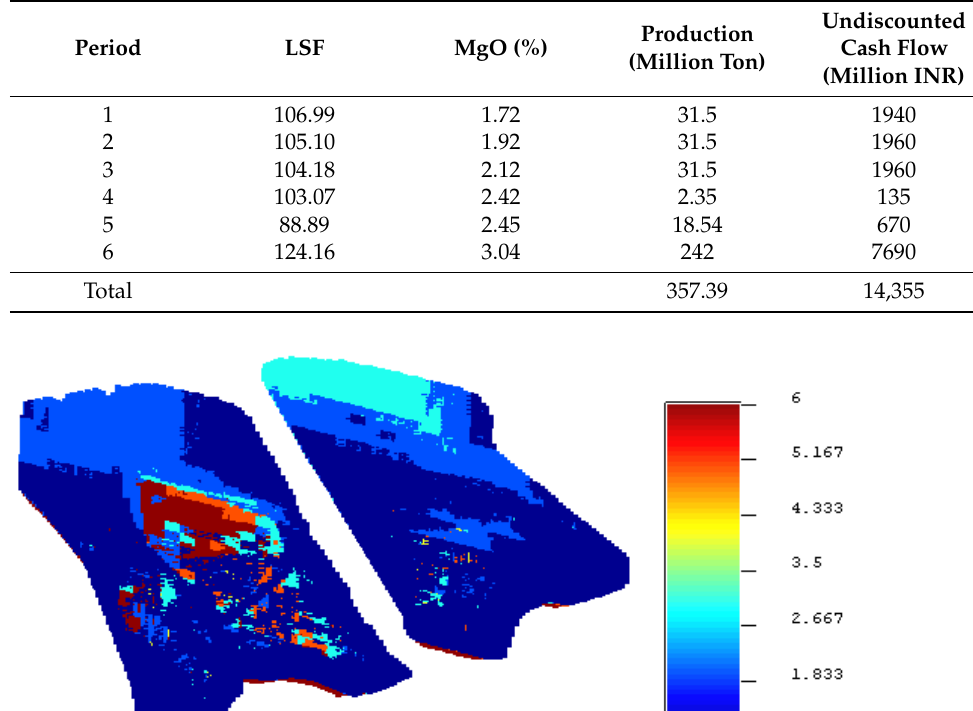
Table 2. Production scheduling results from Model 1.